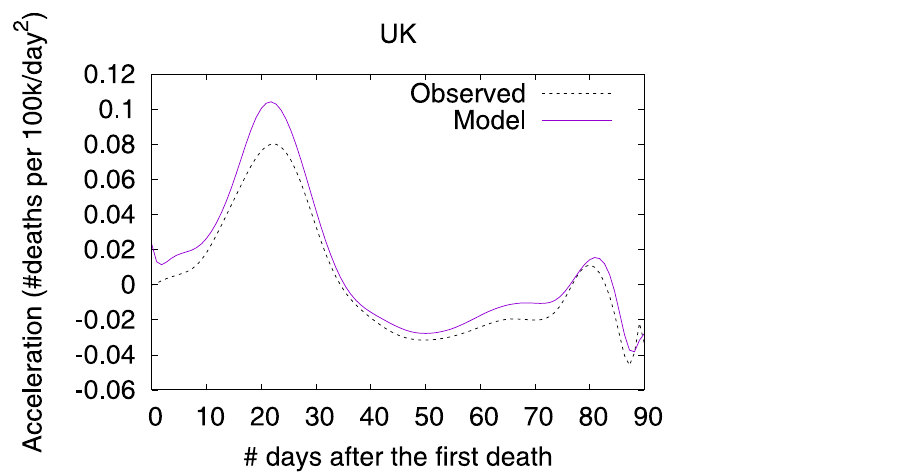
Fig 17. (Color online) projections for acceleration in the UK.